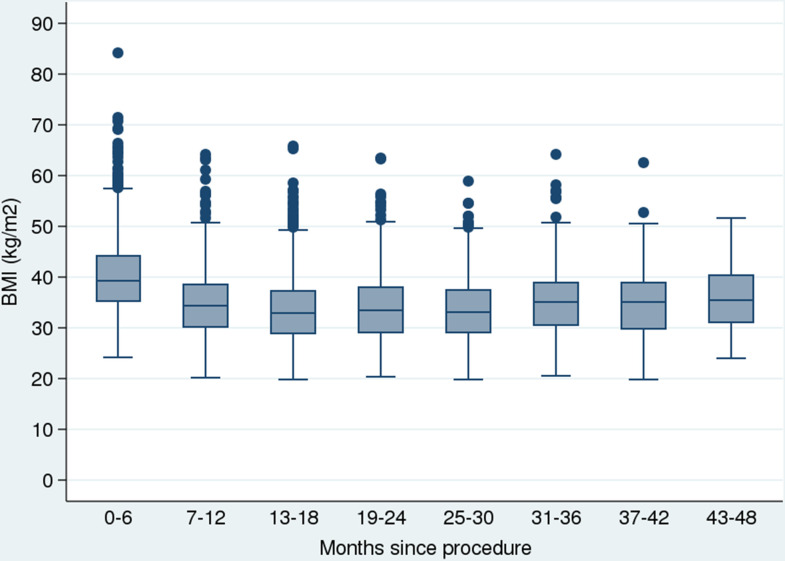
BMI in patients over time since bariatric procedure.Box and whisker plot (median and IQR) to illustrate BMI of patients among those with a follow-up visit during each time period from bariatric procedure. Whiskers represent the upper and lower adjacent values, with dots showing observations beyond these values. Numbers at each visit were the following: month 0 to 6 n = 2,133; month 7 to 12 n = 1,442; month 13 to 18 n = 1,112; month 19 to 24 n = 637; month 25 to 30 n = 633; month 31 to 36 n = 250; month 37 to 42 n = 189; month 43 to 48 n = 108. BMI, body mass index; IQR, interquartile range.